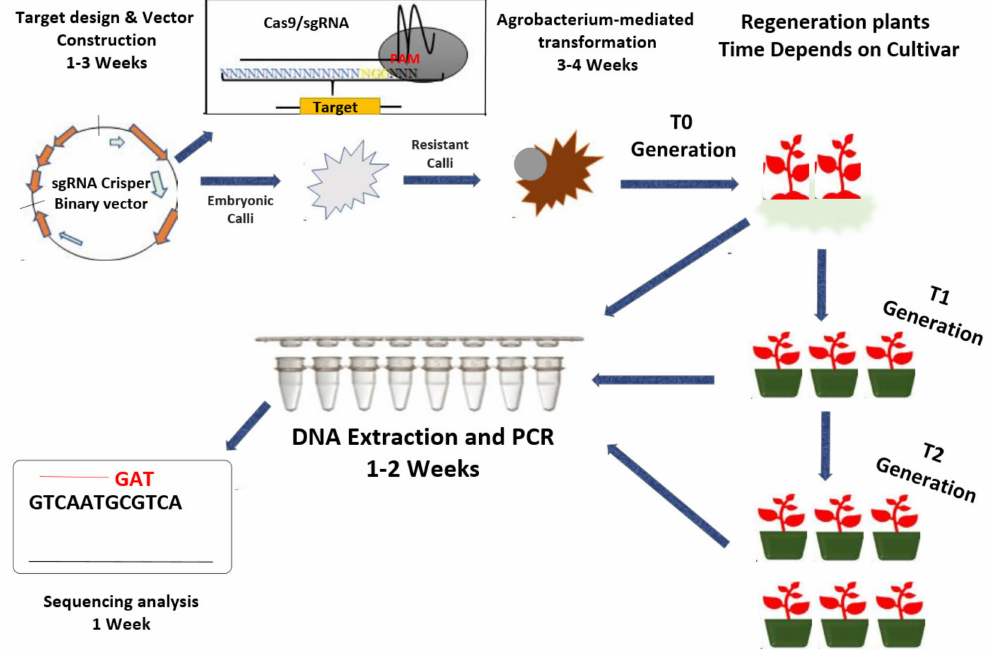
Figure 4. CRISPR–Cas9-based genome editing. CRISPR / Cas9 system uses Cas9 and sgRNA to cleave foreign DNA. It works in three steps: (1) the expression of the nuclear-localized Cas9 protein, (2)